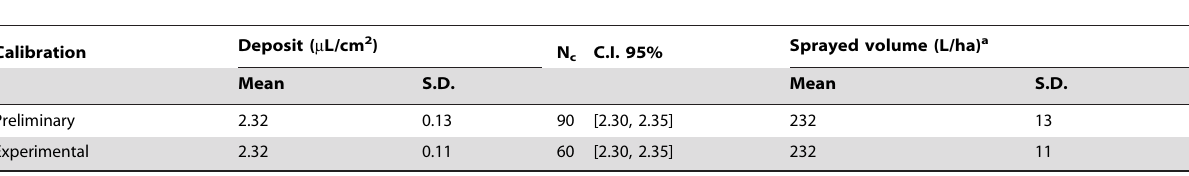
Table 3. Comparison of preliminary calibrations and experimental controls of the deposit.